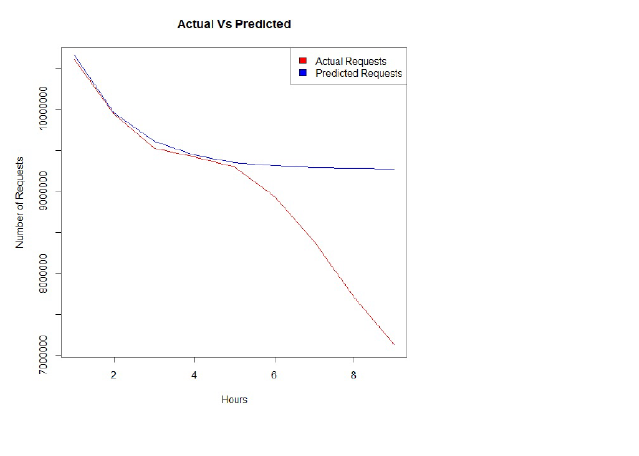
Figure 1. Actual VS One Time prediction